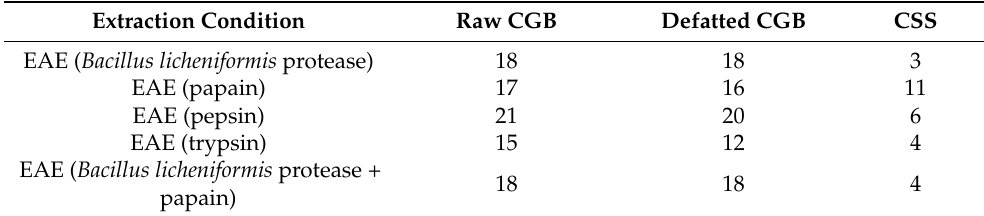
Table 3. Amount of free amino acids (% of total amino acids) in the dry protein extracts. Extraction Condition Raw